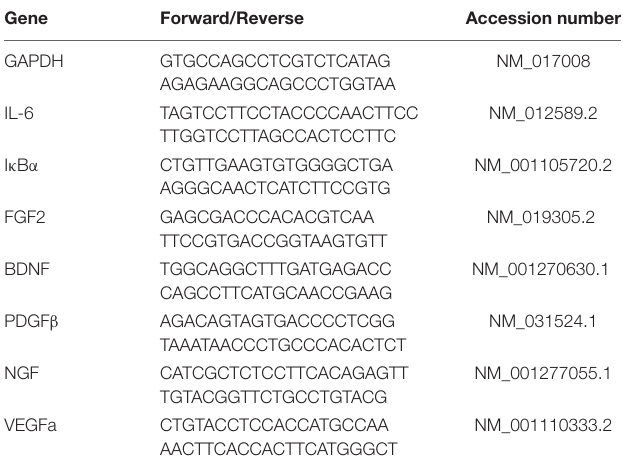
TABLE 1 | Primer sequences for genes of interest in Experiments 1 and